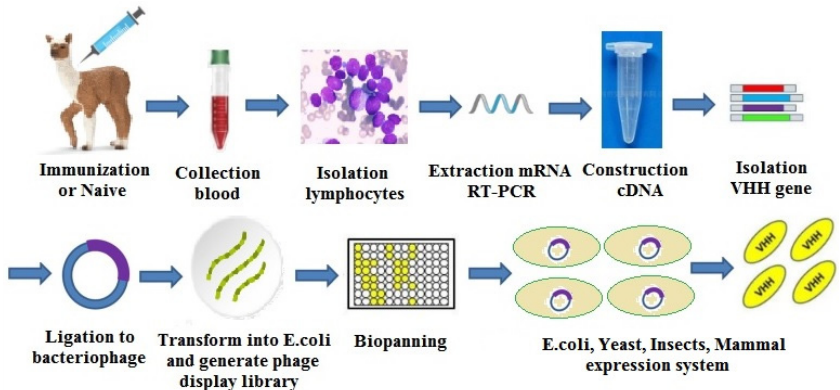
Figure 13. The single-domain antibody (sdAb) preparation process.